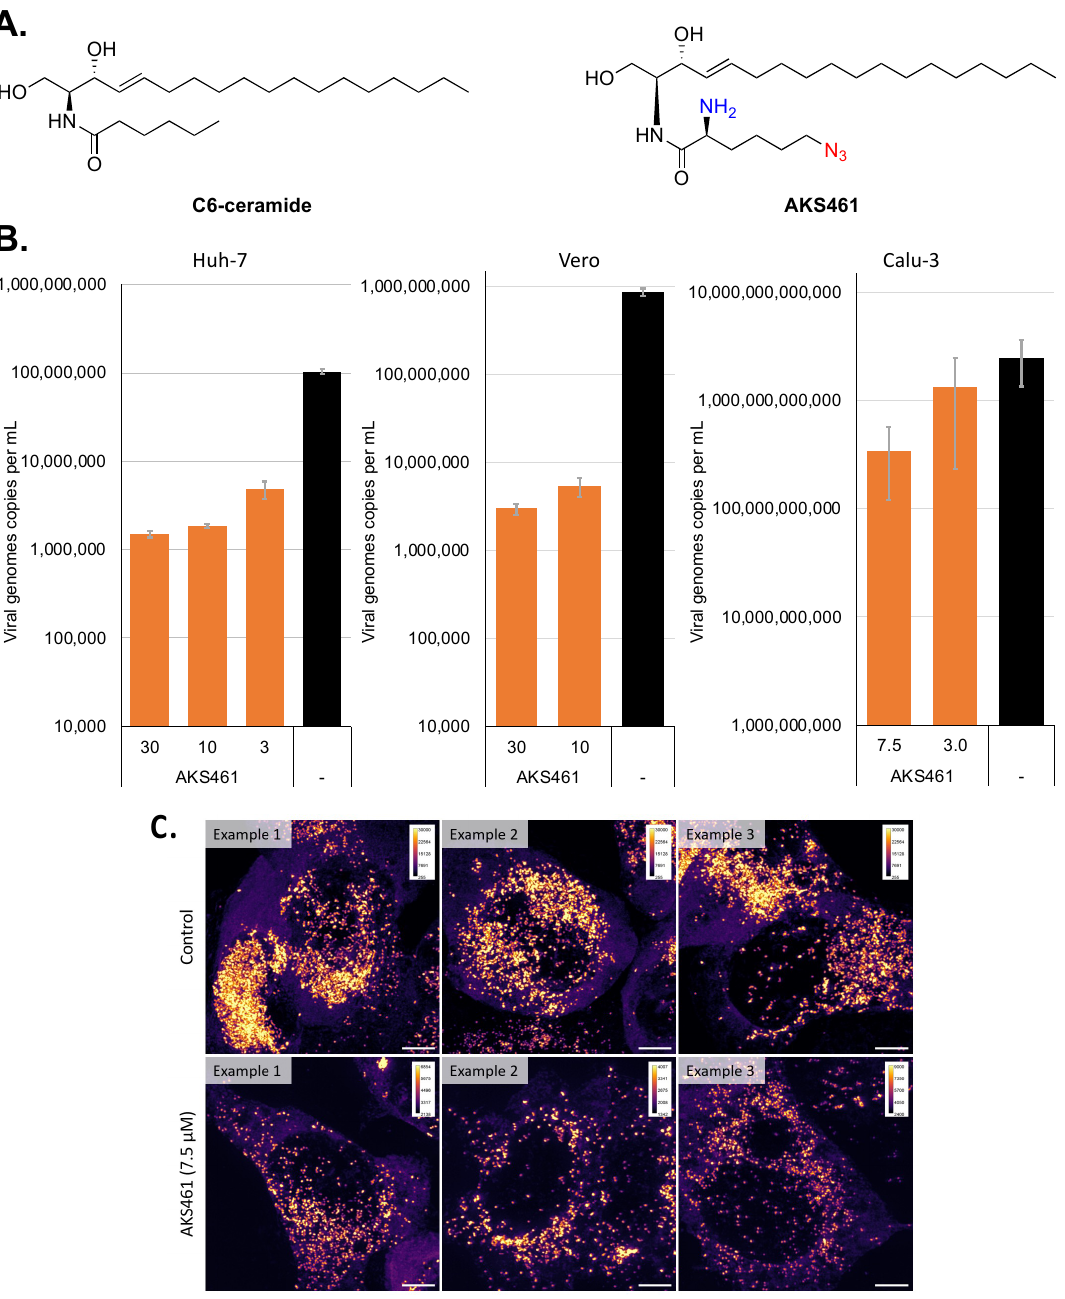
Figure 1. AKS461 inhibits SARS-CoV-2 replication. ( A ) Chemical structures of C6- and AKS461 ceramides. ( B ) Huh-7, Vero, and Calu-3 cells were incubated with AKS461 and infected with SARS- CoV-2 (MOI = 1). All infections were performed in triplicates. Viral loads were determined by RT-qPCR. ( C ) Intracellular SARS-CoV-2-RNA-FISH (three examples). Super-resolution SIM images of SARS-CoV-2 infected Vero cells labeled with CoronaFISH-Cy5.The CoronaFISH-Cy5 signal is reduced after treatment with 7.5 µM AKS461. Scale bar 5 µm.